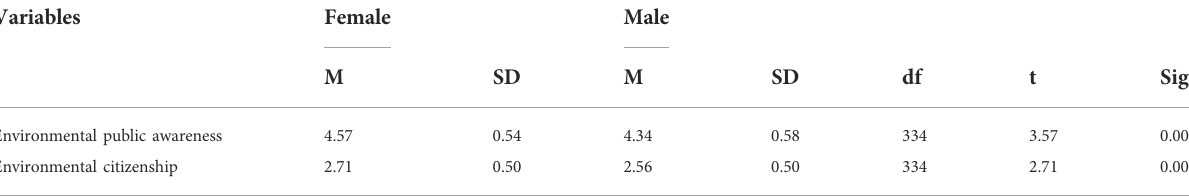
TABLE 3 t -test results comparing gender groups on environmental public awareness and citizenship.